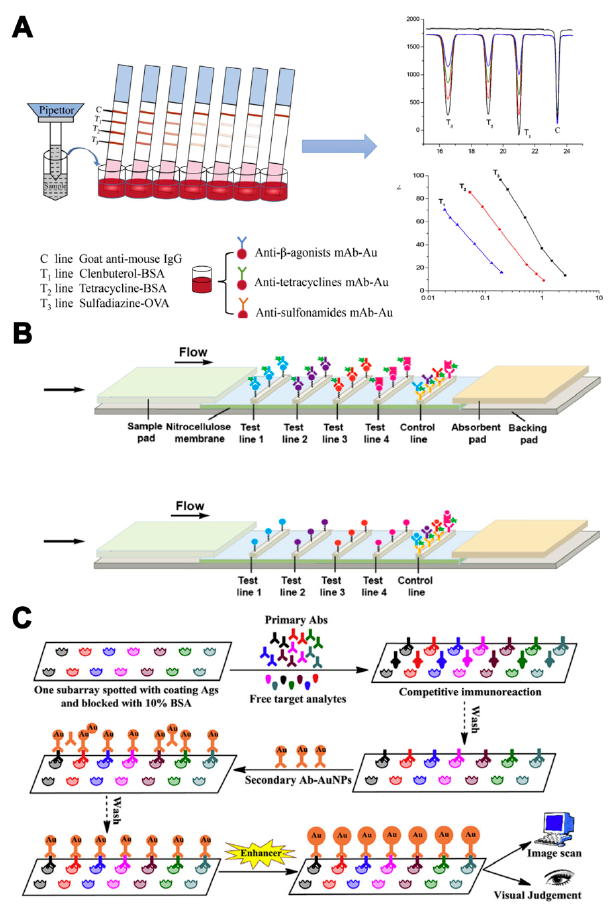
Figure 3. The assays based on multi-antibodies in single-label strategies. ( A ) Illustration of colorimetric assays for multi-residues detection using a AuNPs-based multiplex lateral flow immunoassay (LFIA) [54]. ( B ) Illustration of a multiplex near-infrared (NIR) fluorescence-based LFA for the detection of four families of antibiotics [55]. ( C ) Illustration of a competitive